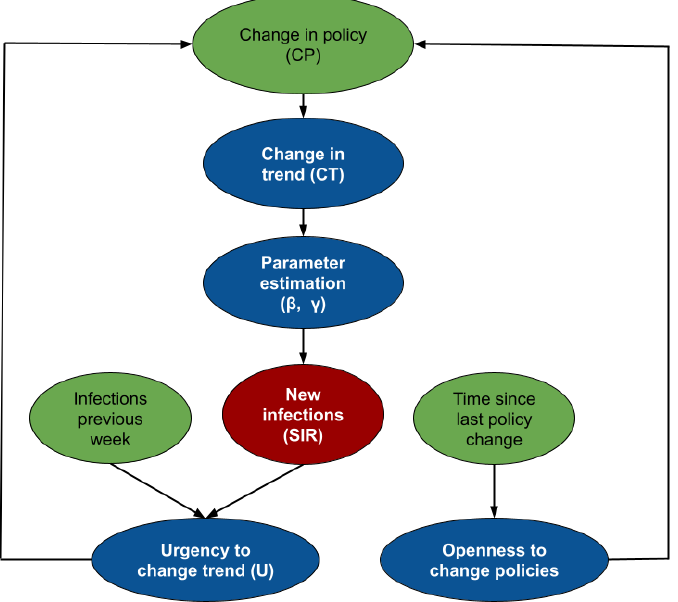
Figure 2. Intuition behind SIMLR. The policies currently in place determine the value of the parameters needed to infer the next values, using an SIR model. Those predictions are then used to estimate how the policies might change in the